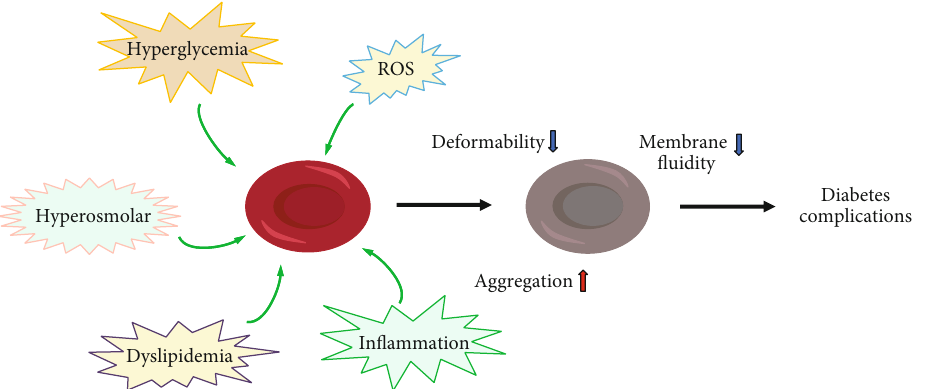
Figure 1: Risk of erythrocytes in diabetic patients and its e ff ects on cellular functions. The erythrocytes in diabetic patients face multiple risks, such as hyperglycemia, hyperosmolarity, oxidative stress, in fl ammation, and lipid metabolism disorder, which lead to increased aggregation, reduced cell deformability, and reduced membrane fl uidity. These changes in erythrocytes eventually give rise to microcirculation disorder and diabetic